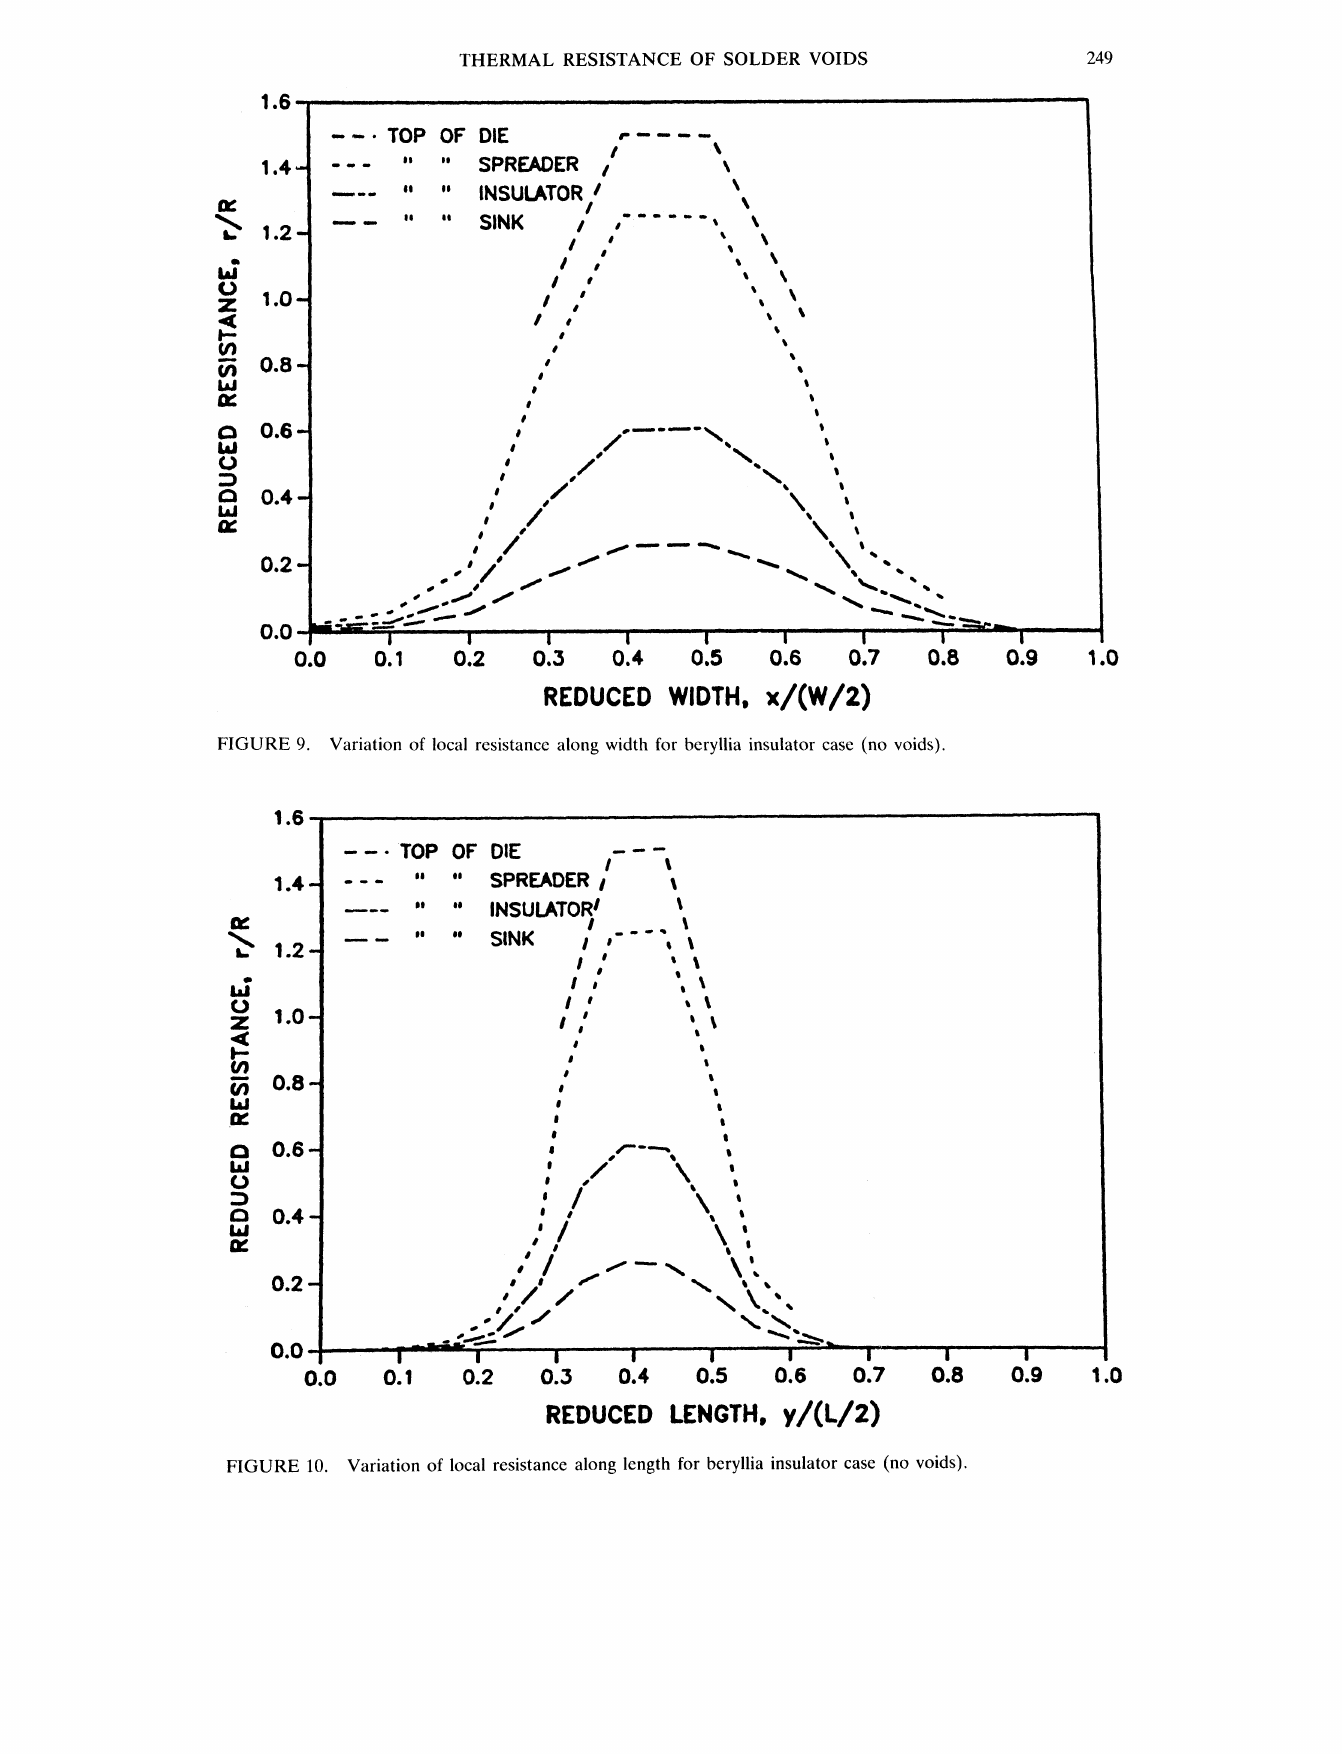
FIGURE 10. Variation of local resistance along length for beryllia insulator case (no